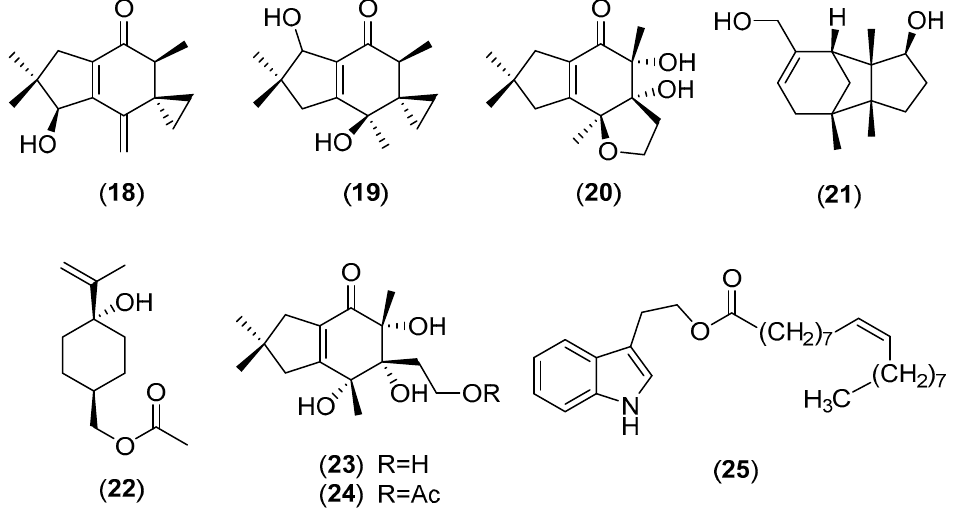
Figure 5. Chemical structures of selected compounds isolated from Craterellus cornucopioides.